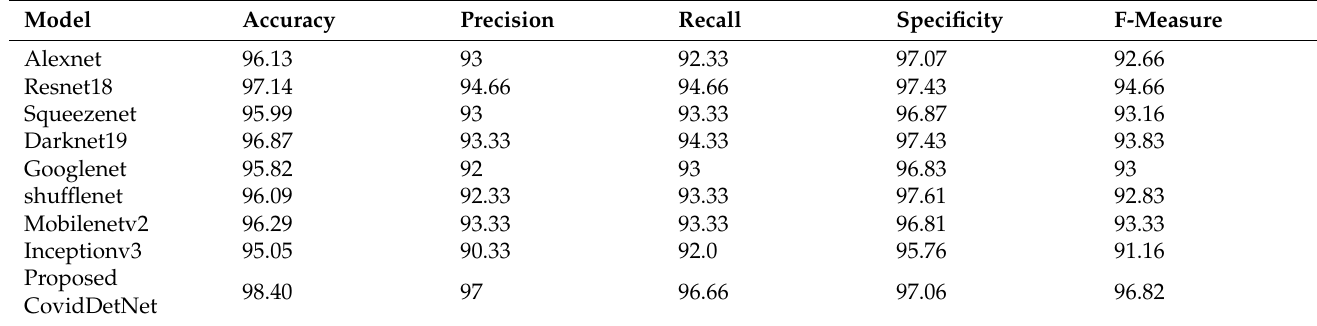
Table 10. COVID-19 detection using chest radiographs comparison with hybrid